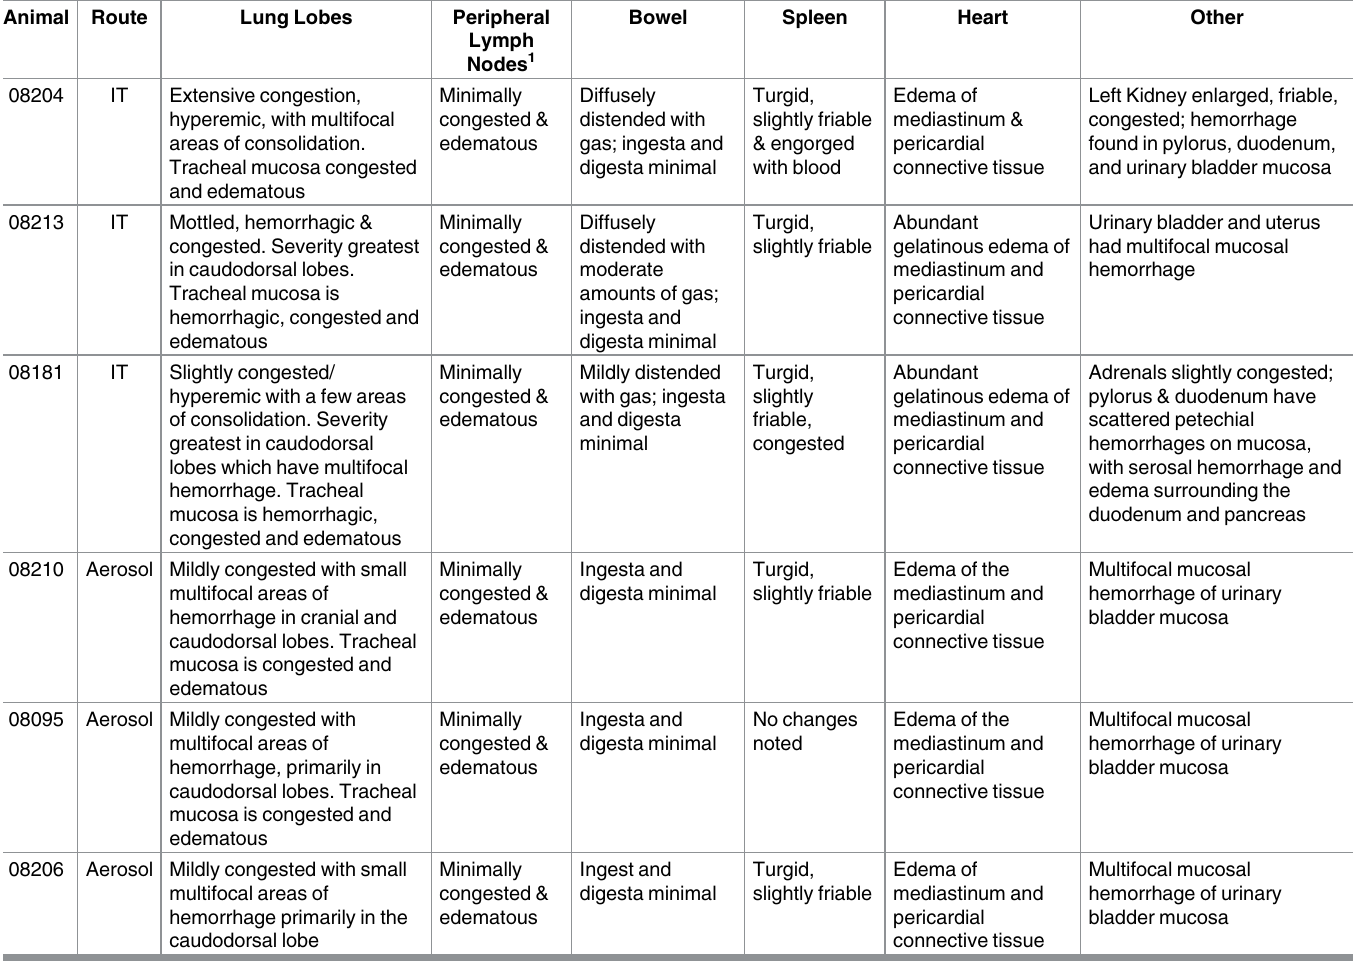
Table 2. Gross pathologic assessment at necropsy. Animal